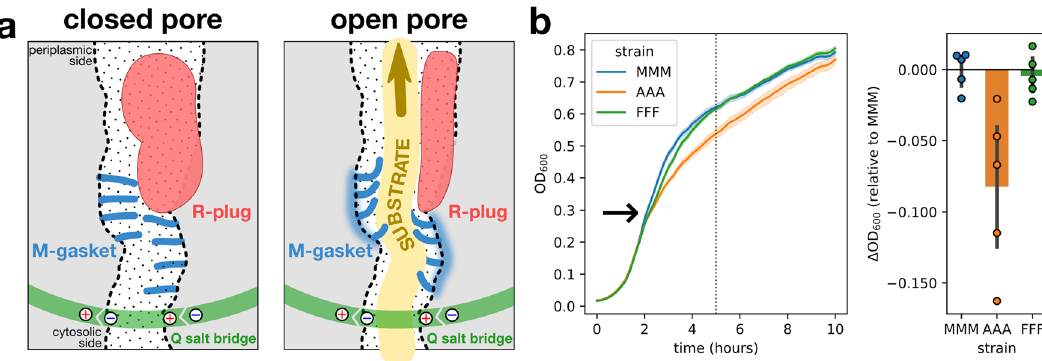
Fig. 8 The T3SS secretion pore conserves membrane barrier during type-III secretion to maintain fi tness. a Model of fT3SS secretion pore regulation to preserve membrane barrier. In closed conformation, the M-gasket (blue) and the R-plug (red) cooperate to seal the channel and prevent alteration of membrane barrier. Upon substrate translocation (yellow), the M-gasket and R-plug undergo conformational changes to enable opening of the channel. Salt bridges in FliQ (green) are critical to support M-gasket deformation and maintain the secretion pore tightly assembled. b The loss of membrane barrier caused from leaky fT3SS secretion pores results in altered fi tness. Left: growth of several M-loop variants was followed over time by monitoring the OD 600 . The arrow indicates the growth phase (OD 600 = 0.3) at which expression of the fl agellar master regulator FlhD 4 C 2 starts increasing 35 . Right: the FliP AAA mutant, that is impaired in secretion pore gating, has a growth defect compared to the WT (MMM) and the FFF variant. n = 5 biological replicates. The bars represent the mean value of the individual measurements and the error bars the standard deviation. The error bands (left) represents the 95% con fi dence